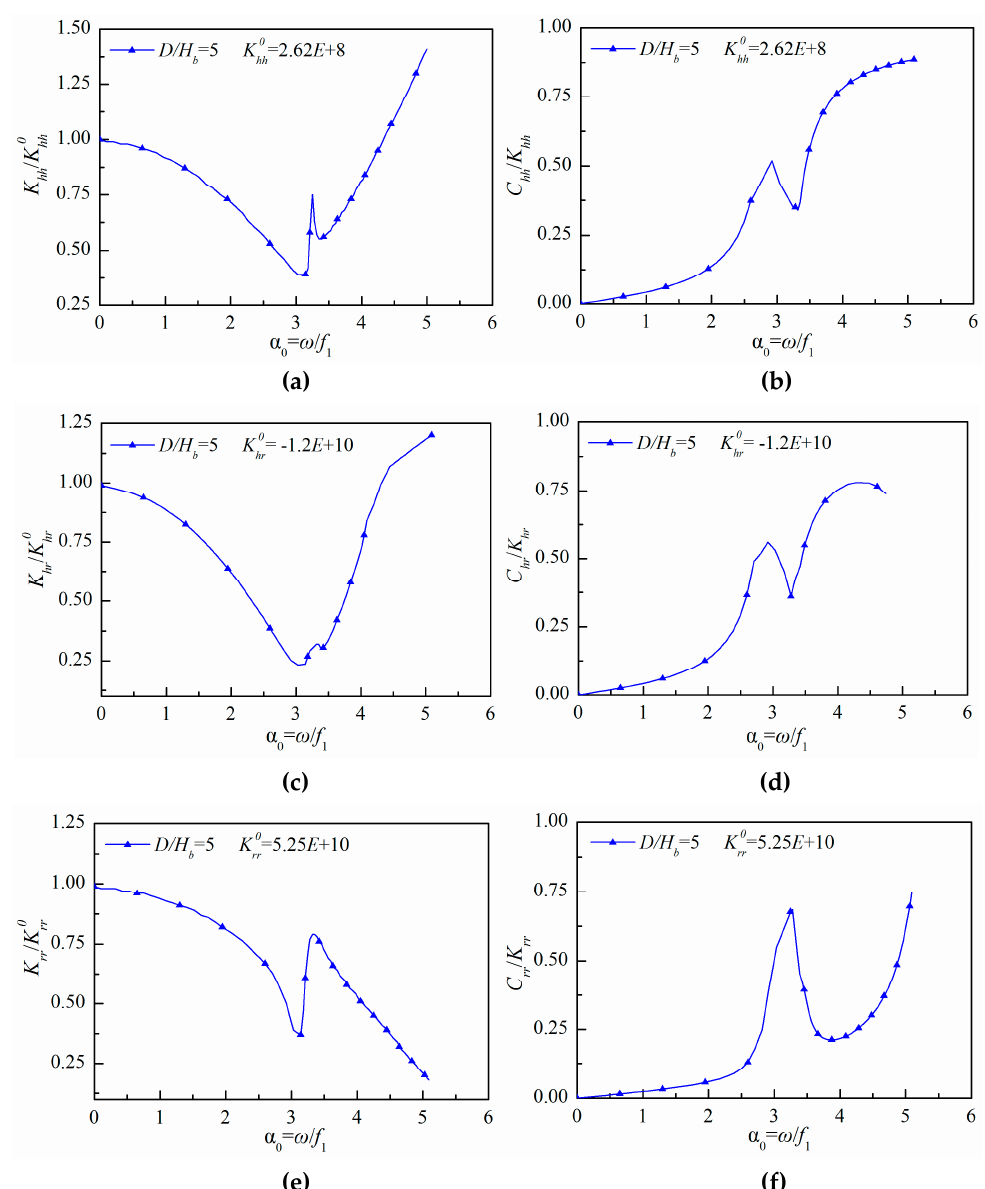
Figure 7. Variation of three dynamic impedance coefficients with respect to the dimensionless frequency: ( a ) Horizontal stiffness coefficient; ( b ) horizontal damping coefficient; ( c ) coupling stiffness coefficient; ( d ) coupling damping coefficient; ( e ) rocking stiffness coefficient; ( f ) rocking damping coefficient.